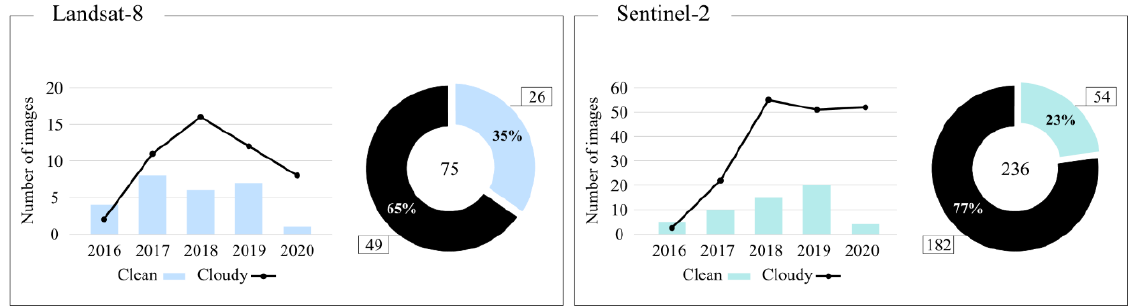
Figure 4. Multispectral Landsat-8 and Sentinel-2 images affected by atmospheric conditions from